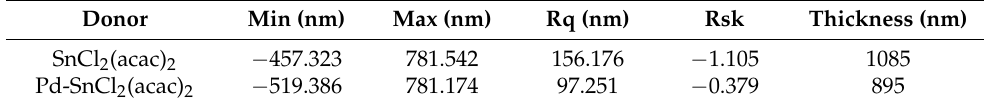
Table 1. AFM parameters that describe the surface morphology for (40 µm × 40 µm) scanned areas. Donor